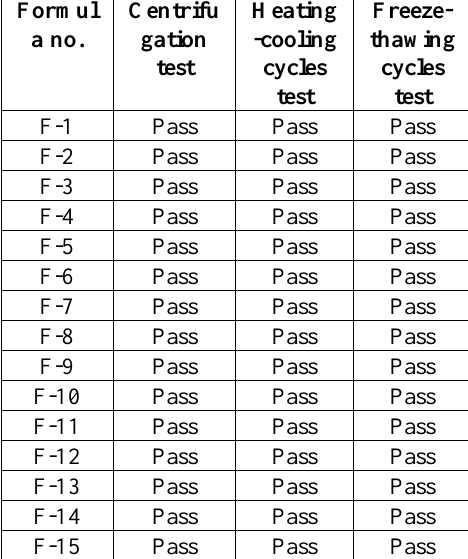
Table 4. Result of thermodynamic study for all CC.